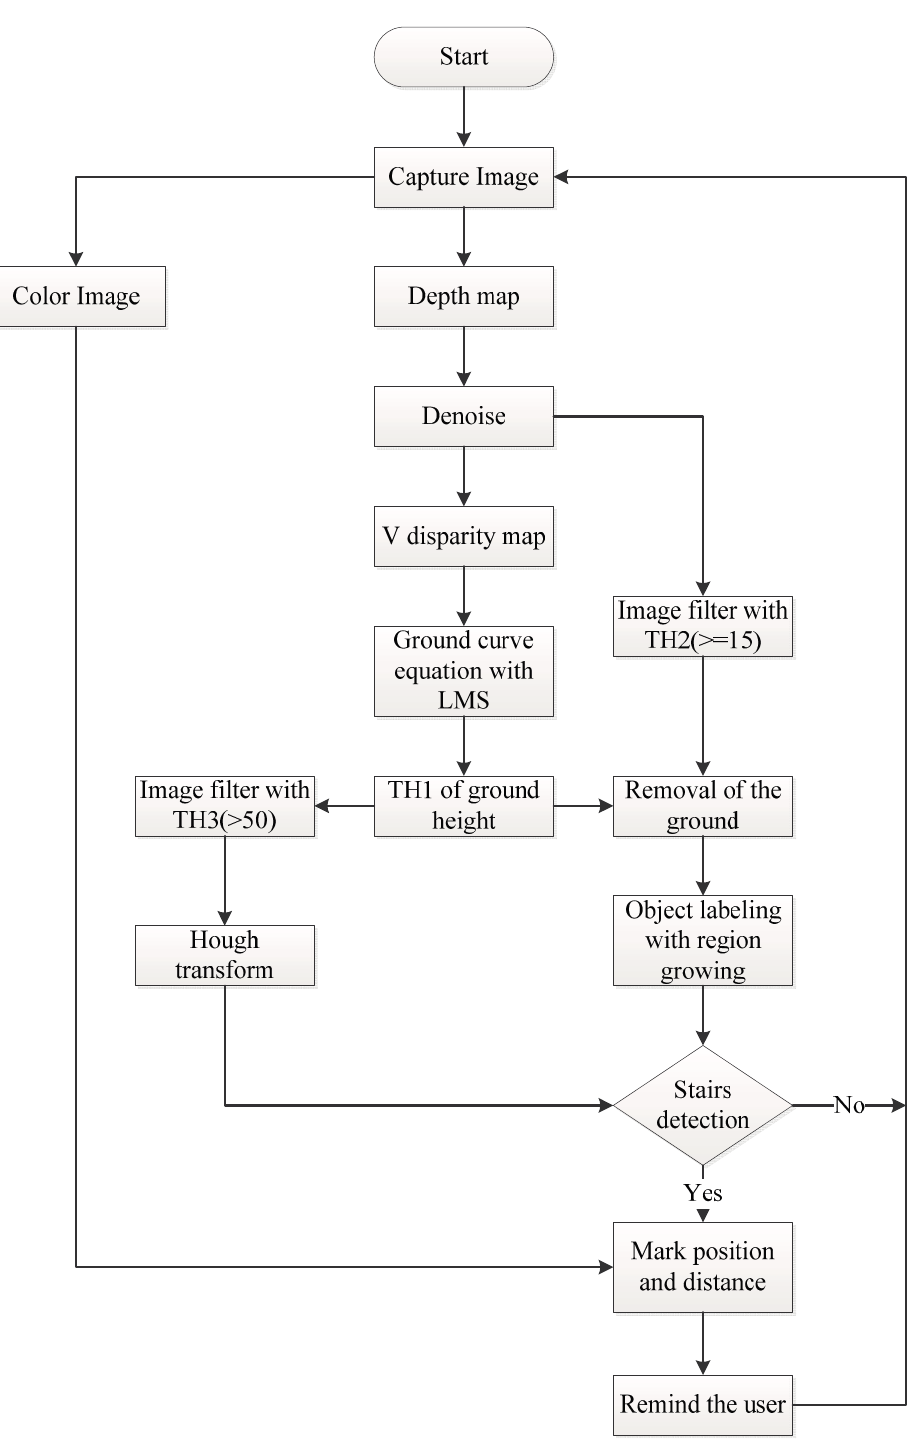
Figure 1. The system